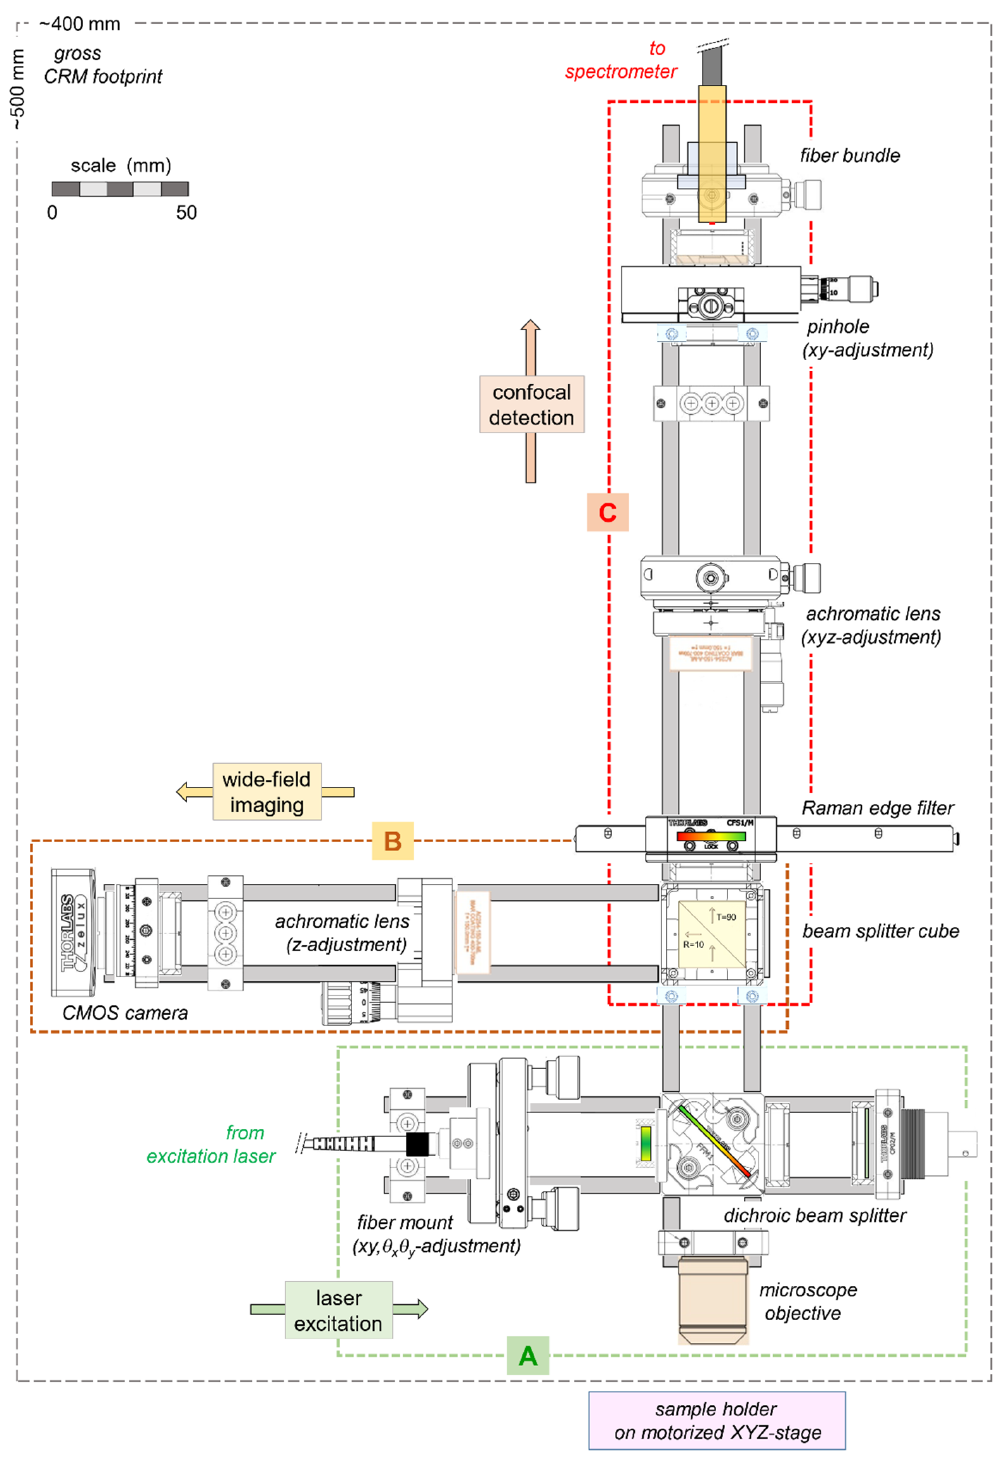
Figure 1. Overview of the confocal Raman microscope constructed from opto-mechanical cage system components and optical elements of the Thorlabs collection; note that the DPSS excitation laser, the Raman spectrometer, and the motorized sample stage are not included here. The conceptual CRM groups are: A —excitation laser coupling and Raman light collection; B —the wide-field imaging arm; C —the confocal light collection arm. Key optical components are annotated, together with their spatial adjustment; for further details, see main text.